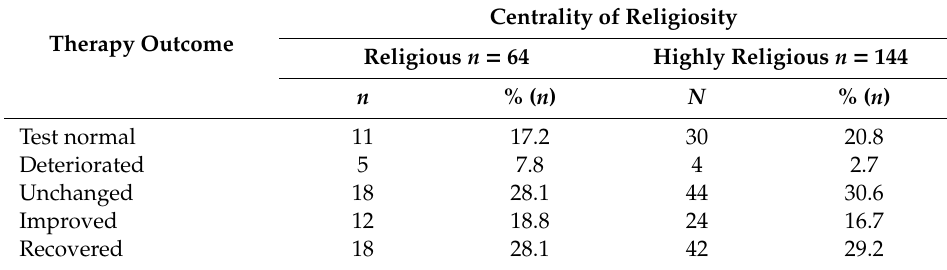
Table 4. Frequency distributions of therapy outcome groups with respect to centrality of religiosity (admission to the clinic (t1)).